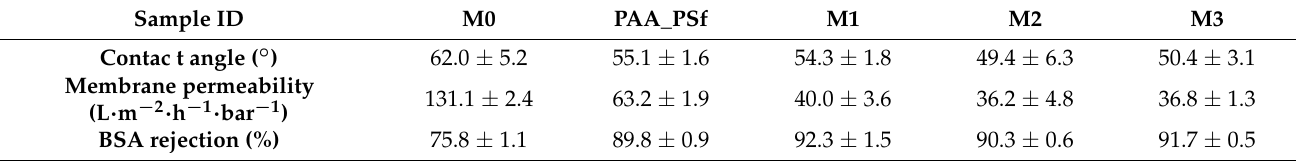
Table 4. Contact angles, membrane permeability and BSA rejection of the tested membranes.